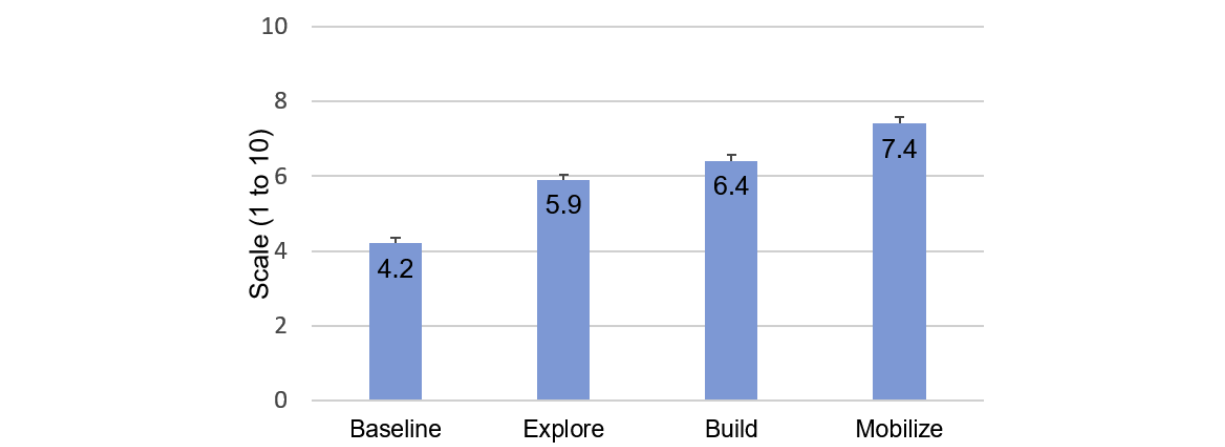
Figure 6. Changes in confidence to quit. Estimate of means and standard errors based on linear mixed model.